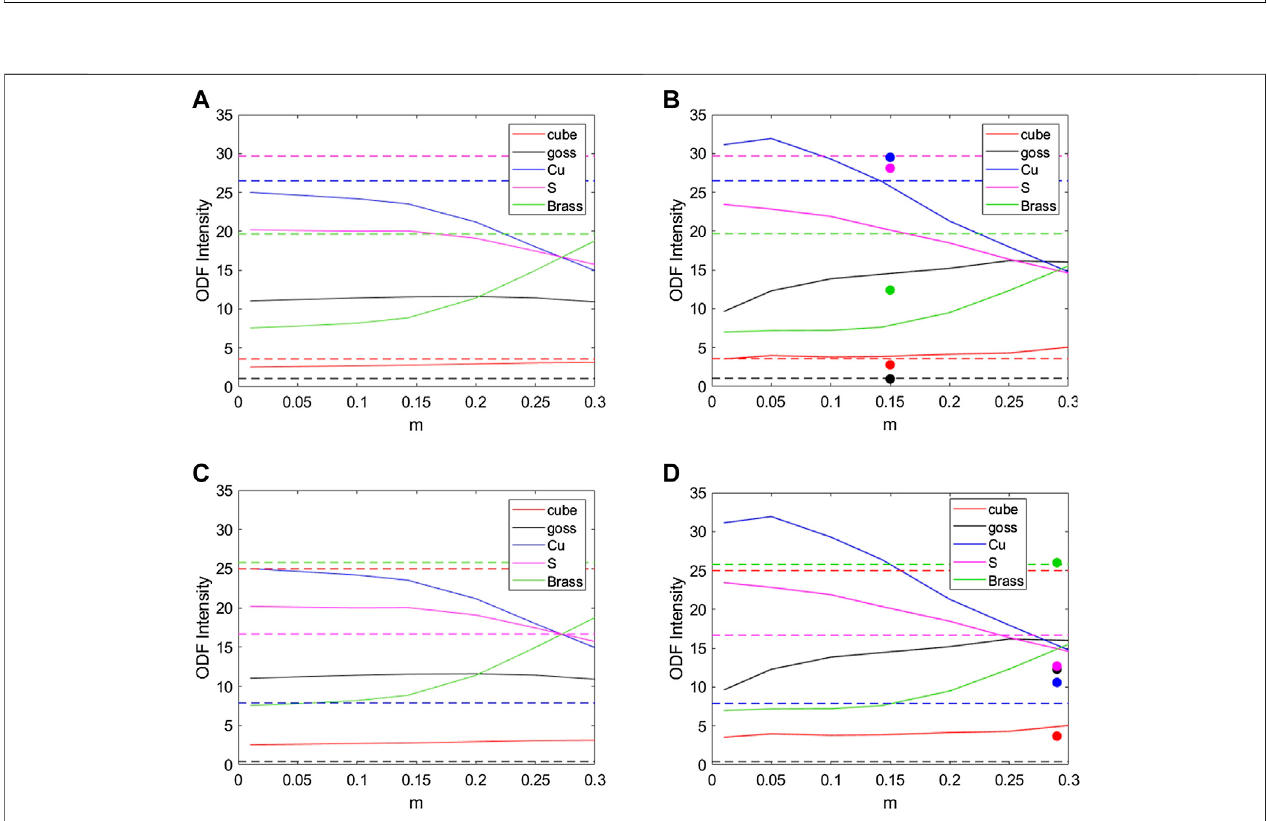
FIGURE3| Intensitiesoftexturecomponentsasfunctionsofthestrain-ratesensitivity.PredictedbytheAlamelmodelbysolidlinesin (B) and (D) ,andcomputedby theFC-Taylormodelbysolidlinesin (A) and (C) comparedtomeasuredvalues(dashedhorizontallines)for (A) and (B) T350 ° Cand (C) and (D) T500 ° C.The fi lledcircles in (B) and (D) indicate the results from the Alamel model with the optimal parameters including nonoctahedral slips ( Table 3 ).